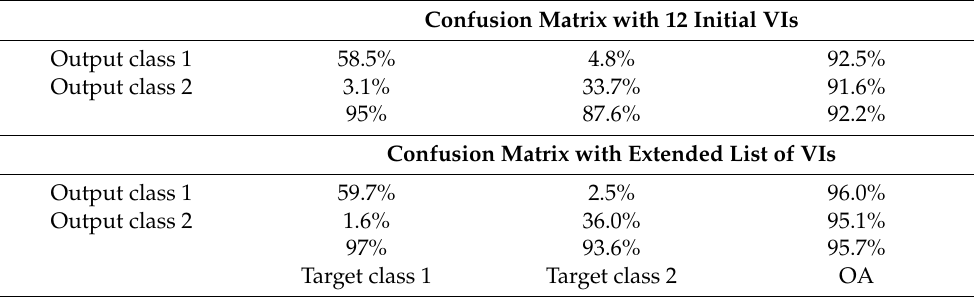
Table 7. Results obtained from the application of the neural network, trained with VIs computed on PRISMA images, on the two regions in New Zealand. As in the previous cases, the characteristics of the neural network included 60% of the samples for training, 20% for validation, and 20% for testing, with 20 hidden